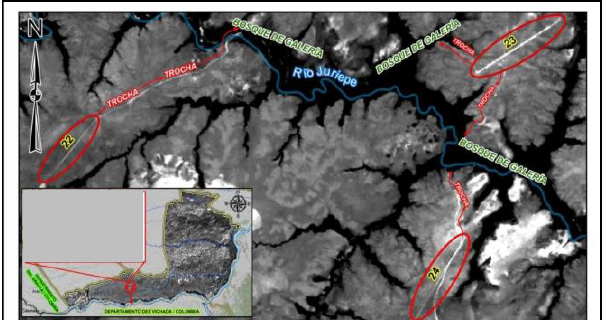
Figure 5. Unauthorized airstrips